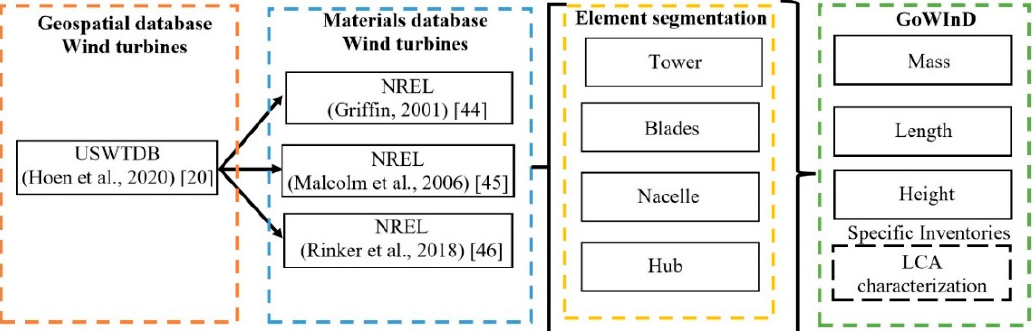
Figure 1. Methodology to integrate Global Wind Inventory for Future Decommissioning (GoWInD) and its validation implementation applying databases from the US, materials database considers NREL models [44–46] .